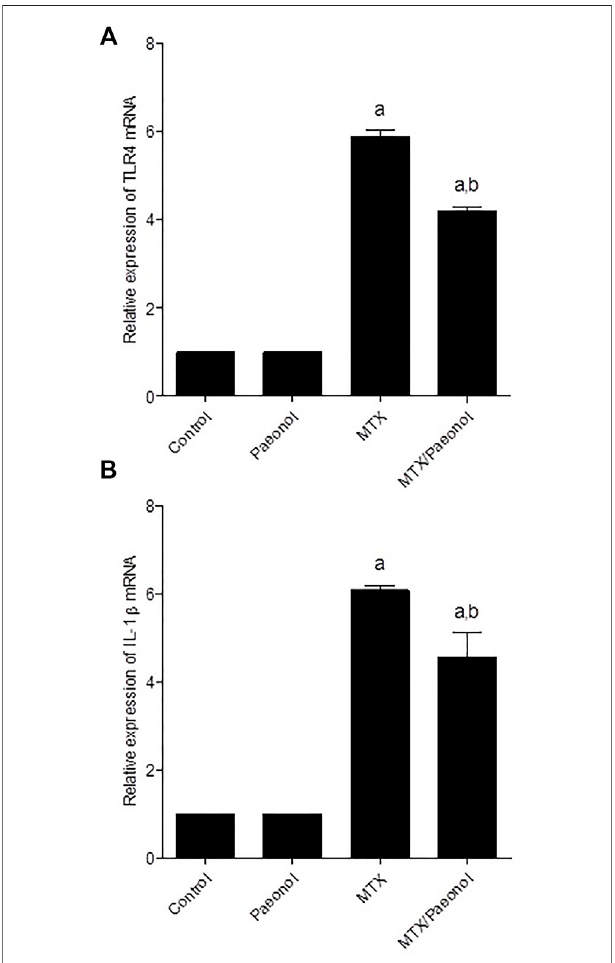
FIGURE 4 | Renal toll-like receptor 4 (TLR4) and interleukin-1 β (IL-1 β ) mRNA expression in the rat kidney after methotrexate (MTX) and/or paeonol administration. The mRNA expression of (A) TLR4 and (B) IL-1 β was measured relative to that of glyceraldehyde 3-phosphate dehydrogenase (GAPDH). Results show means of six observations ± SEM. Values are considered signi fi cantly different when p < .05. a,b Signi fi cant difference compared to control or MTX groups,